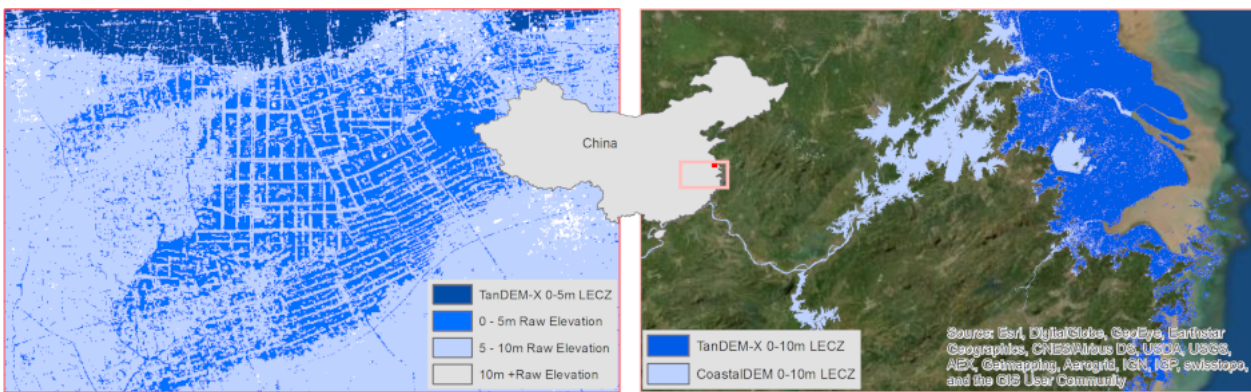
Figure 10. Comparison of LECZ data sources along the Yangtze River, China, for CoastalDEM and TanDEM-X elevation sources. Basemap from Esri, DigitalGlobe, GeoEye, Earthstar Geographics, CNES/Airbus DS, USDA, USGS, AEX, Getmapping, Aerogrid, IGN, IGP, swis- stopo and the GIS User